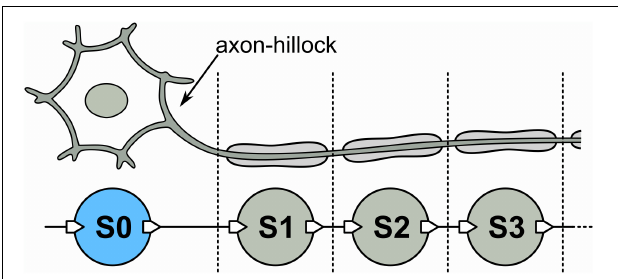
FIGURE 3 | Top: Schematic long-axon neuron. Bottom: Implementation of a long-axon neuron by a uni-dimensional network of UCN units. S0 is the soma + axon-hillock, S1, S2, ... are axon segments. The list of components of the UCN blocks are provided in the Supplementary Material